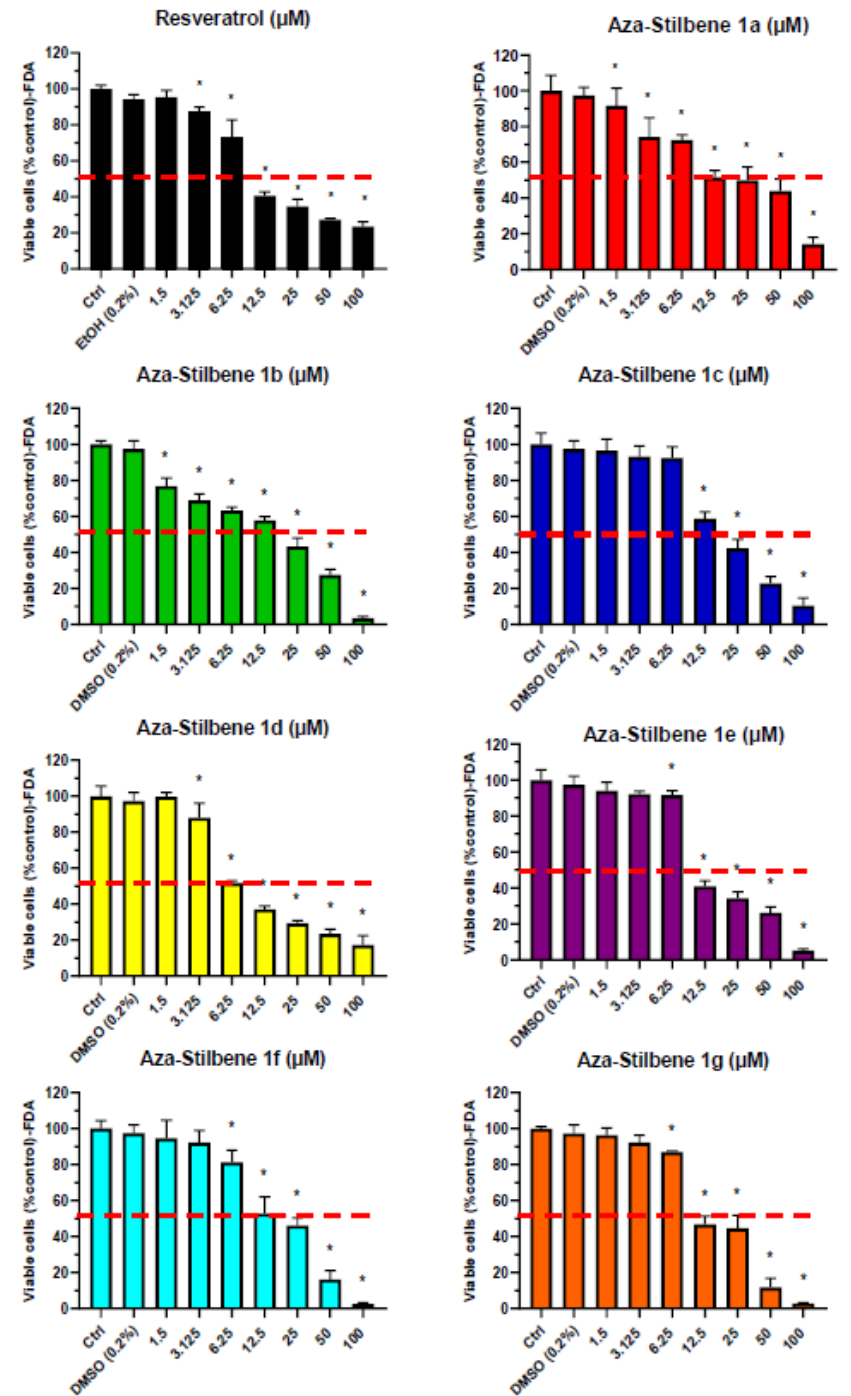
Figure 4. Evaluation with the fluorescein diacetate (FDA) assay of the effects of resveratrol and aza ‐ stilbenes 1a to 1g on cell viability . N2a cells were incubated for 48 h with or without resveratrol or aza ‐ stilbenes 1a to 1g in a range of concentrations from 1.5 to 100 μ M. The dotted red line makes it